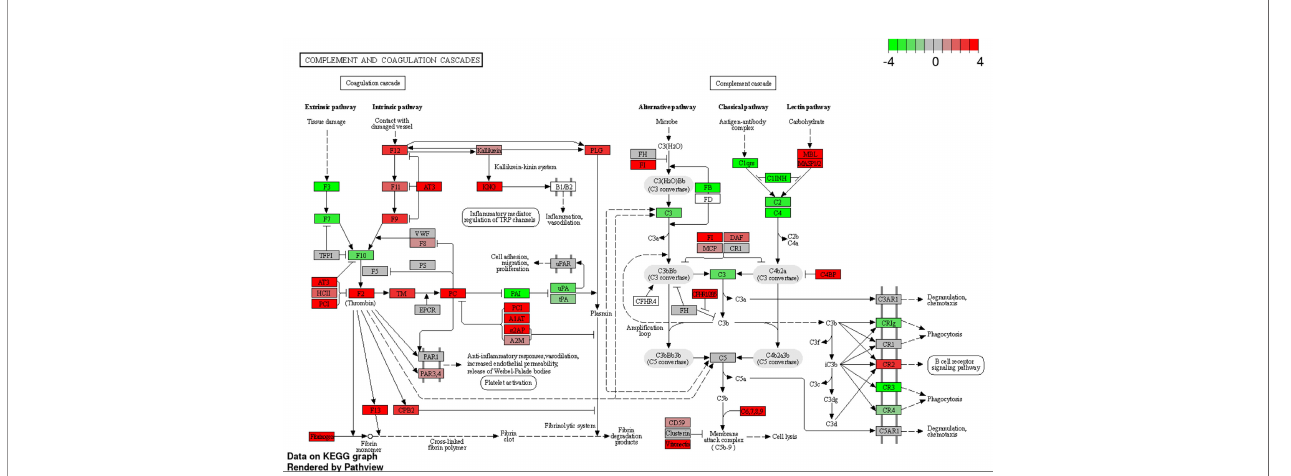
FIGURE 5 | Expression pro fi les of complement and coagulation cascades-related genes at 36 h after infection were visualized on a KEGG pathway diagram using RNA-seq data and the iDEP Pathview package. Red and green indicate genes induced or suppressed by D bgaA -infection compared with those by WT-infection, respectively. Fold-change (log2) cutoff in color code is